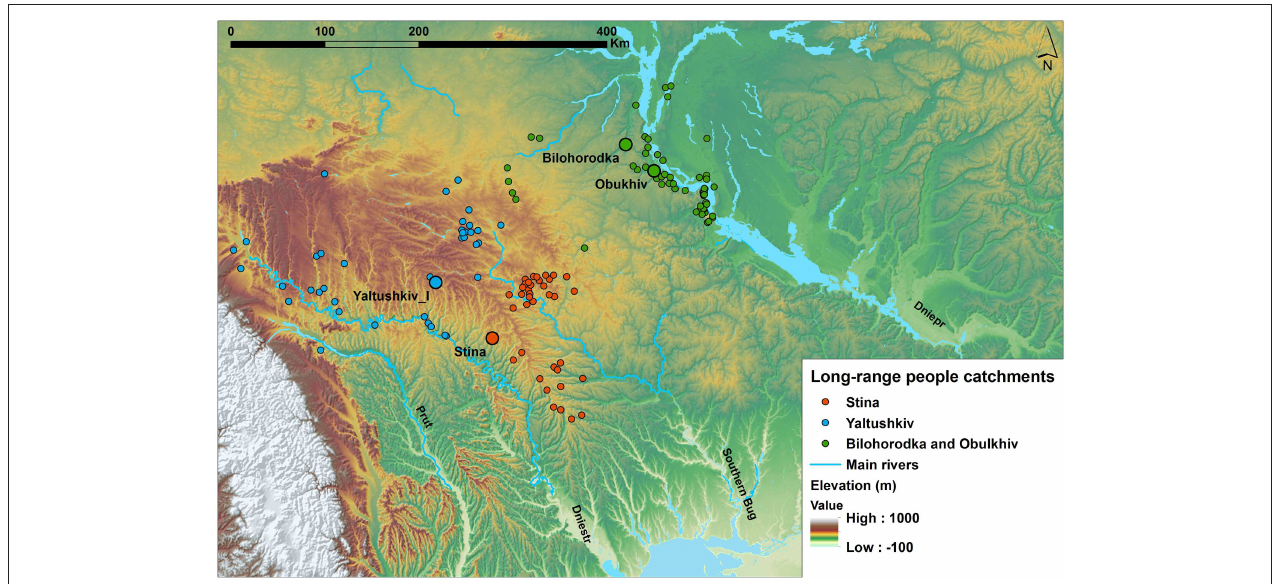
FIGURE 11 | Long-range people catchments, Trypillia Phase CI; larger circles show “isolated” megasites outside the Southern Bug—Dnieper catchment, with the principal megasite named for each region (M.